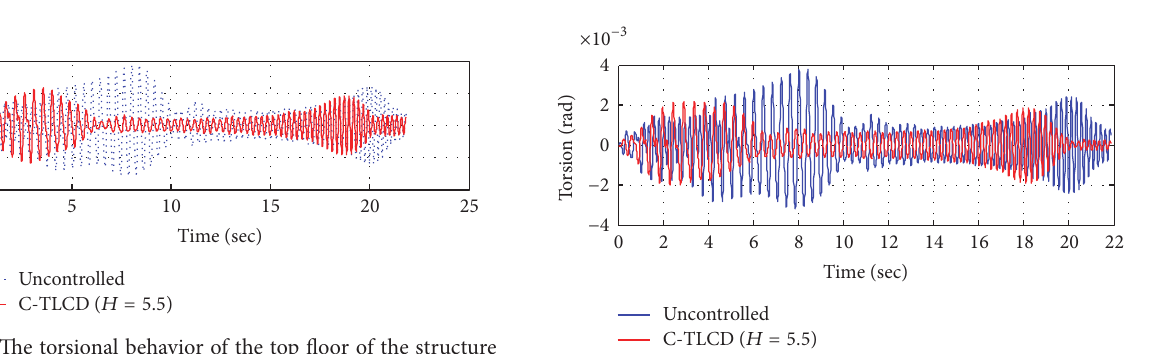
Figure 15: The torsional response of the structure as a function of time for uncontrolled and controlled structure for 𝐻 = 5.5 cm and 𝛽 = 150 ∘